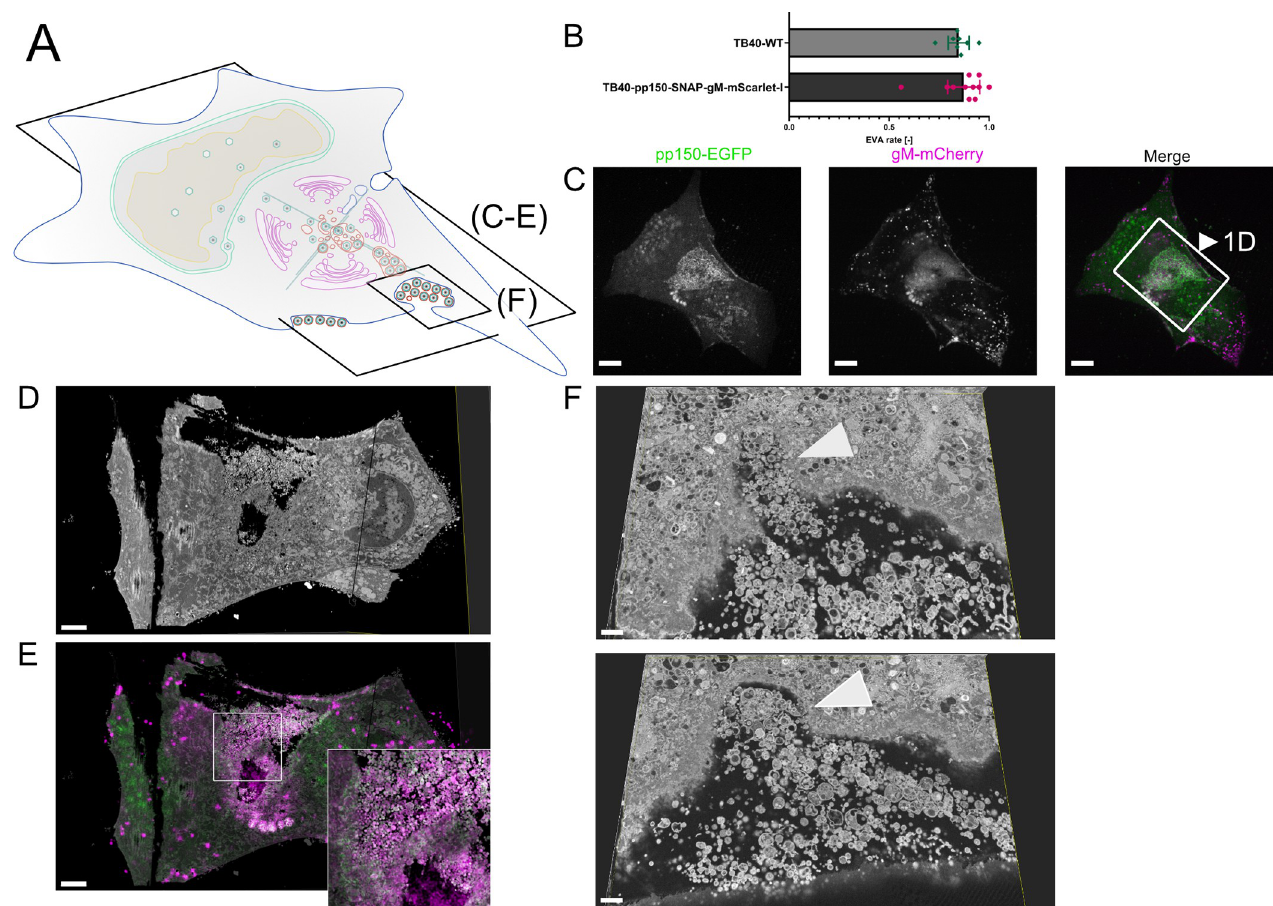
Fig 1. EVAs are extracellular accumulations of viral products and other vesicular material. 1A Overview indicates the subfigures’ positions in relation to the whole cell. 1B Quantification of EVA occurrence. HFF cells were infected with HCMV-pp150-SNAP-gM-mScarlet-I or HCMV-TB40-WT at an MOI of 1 and fixed at 120 hpi. HCMV-TB40-WT infected cells were stained for gB. Large overviews were acquired by spinning-disk microscopy. Late-infected cells were counted, and the rate of EVAs was quantified. Borders show the 95% confidence interval of the mean. N = 269 from 11 replicates for HCMV-pp150-SNAP-gM- mScarlet-I and N = 750 from 8 replicates for HCMV-TB40-WT. No significant difference could be found. 1C Spinning-disk confocal section of HFF-wt cells infected with HCMV-pp150-EGFP-gM-mCherry (MOI = 3) at 4 dpi, showing EVAs positive for pp150-EGFP (green) and gM-mCherry (magenta) close to the plasma membrane. Scale bar represents 10 μ m. 1D/E CLEM of the area marked in 1C. 1D Rendering of SBF-SEM data depicting the area close and below the plasma membrane. Scale bar represents 3 μ m. 1E Correlative overlay of SBF-SEM data from 1D with the corresponding fluorescence data from 1C indicating that pp150-SNAP and gM-mScarlet-I positive EVAs are located outside the cell. Scale bar represents 3 μ m. 1F Two z-slices are depicting invaginations (white arrowheads) next to an EVA that can be found in SBF-SEM data along the cell surface. Scale bars represent 700